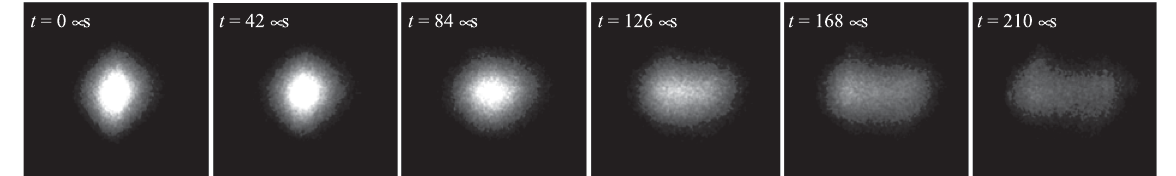
harmonic.FIG. 6. Time evolution of a transverse plasma profile on the phosphor screen measured with a CCD camera. The bare tune of the LPT and the perturbation amplitude are set, respectively, at ν 0 ¼ 8 and w 8 ¼ 0 . 1 V. The initial number of Ar þ ions is increased to 3 . 2 × 10 5 in order to enhance the phosphor images. Note that each image does not reflect the plasma profile at a specific moment but is an axially integrated signal over many rf periods. The two electrode rods with the dipole perturbation are located in the horizontal direction (see Fig.